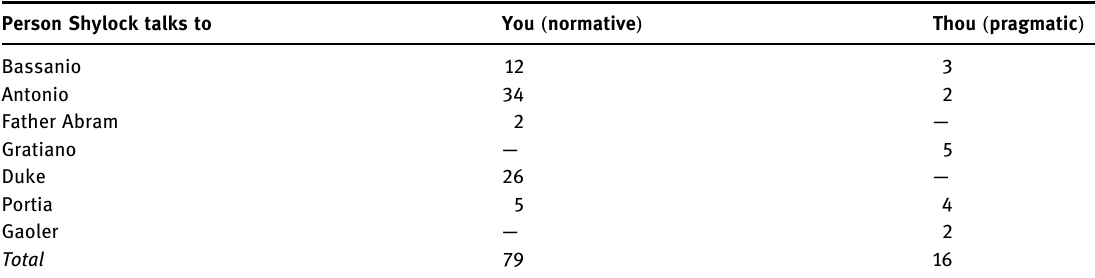
Table 3: Frequencies of normative you and pragmatic thou Person Shylock talks to